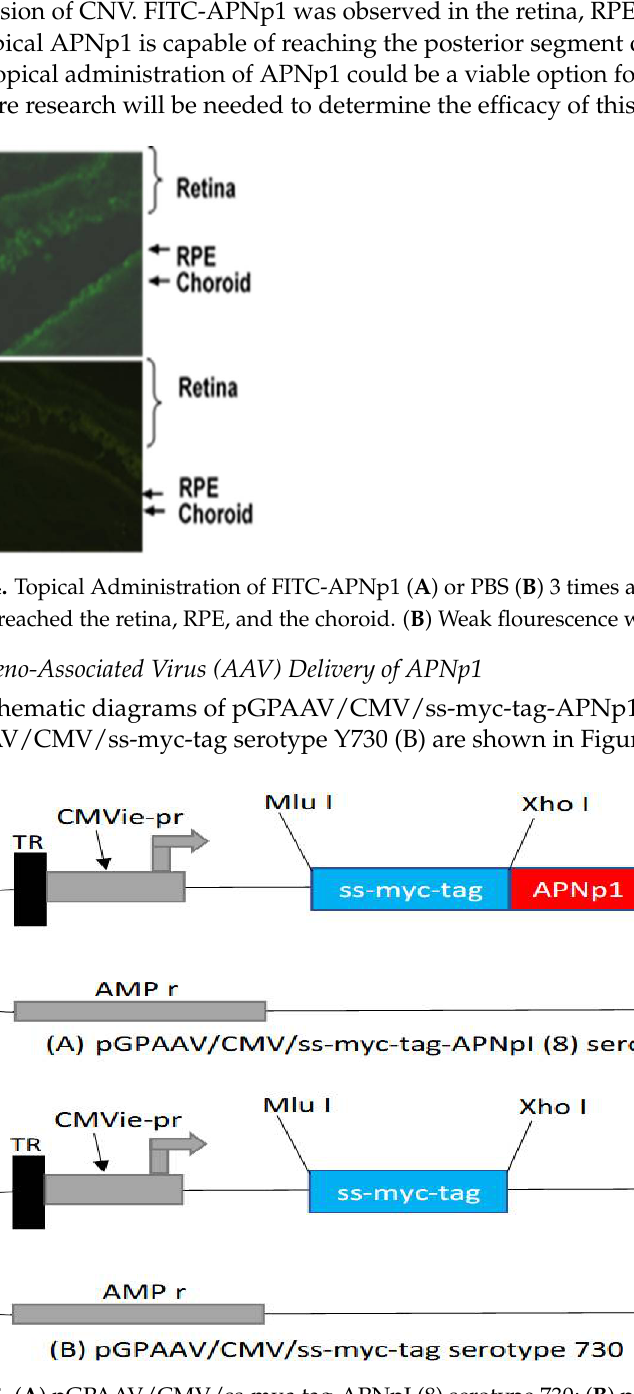
Figure 3. Expression of AdipoR1 and PCNA in Human ARPE-19 cells. Human ARPE-19 cells were fixed and double immunocytochemical staining for AdipoR1 (green color) and PCNA (red color) was performed. DAPI (blue color) was used for nuclei counterstaining. Laser confocal microscopy demonstrated increased levels of AdipoR1 in PCNA-positive cells in pink (indicated by upward arrow) compared to PCNA-negative in blue (indicated by downward arrow) cells. Magnification of objective is 40x.